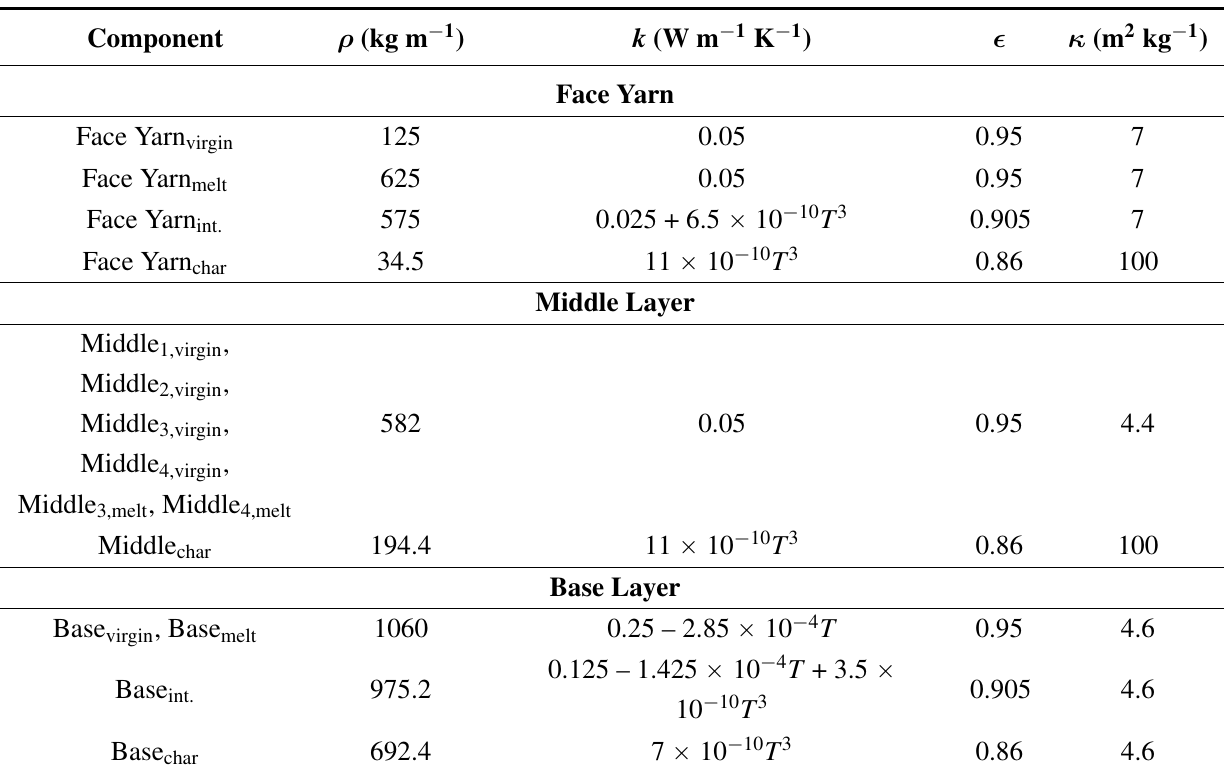
Table 5. Full set of thermophysical properties used in the individual upper layer model and base layer